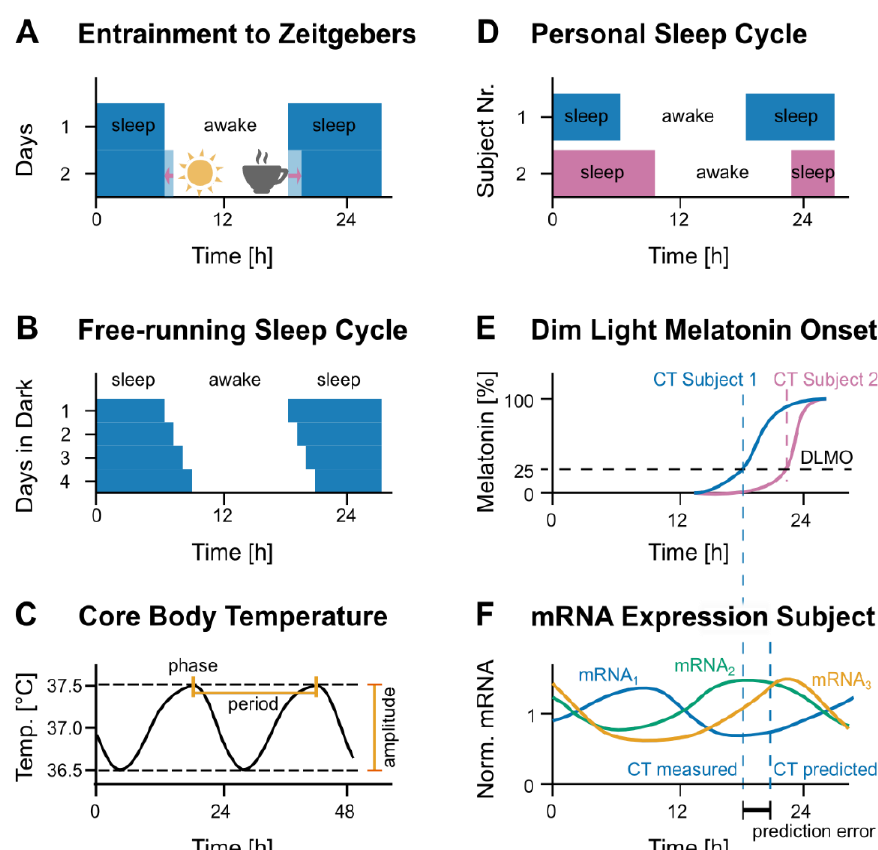
Figure 2. Circadian oscillations in humans. ( A ) The circadian rhythm is evident from the sleep / wake cycle of humans. Subjected to a normal day-night rhythm, humans are awake (white) and sleep (blue) with a period adapted to 24 h. Normally, the first light acts as a strong zeitgeber that entrains the subject to its rhythm. Other zeitgebers include temperature, food or the cup of co ff ee in the evening, which likely delays sleep onset. ( B ) Under constant light conditions, humans retain a rhythm of wake (white) and sleep (blue) phases with a period of around 24 h. In this example, the period is slightly longer than 24 h, thus shifting wake and sleep from day to day. ( C ) The core body temperature shows circadian oscillations. The phase (also named acrophase) is defined as the first peak of the oscillation, the time between two peaks is the period and the amplitude is the di ff erence between peak and trough. ( D ) Indicated are the awake (white) and sleep (colored) phases for two subjects. Subject 1 (blue) has an earlier phase than subject 2 (pink). ( E ) To measure the dim-light melatonin onset (DLMO), subjects are kept under dim-light conditions during the evening, with hourly sampling for subsequent melatonin quantification. The circadian phase is defined as the time when the concentration of melatonin reaches an absolute (e.g., 2 pg / mL) or relative (e.g., 25%) threshold [15]. ( F ) The analysis of circadian oscillations of a set of genes for a given subject (here visualized with profile sketches for three imaginary transcripts, mRNA 1 , mRNA 2 , mRNA 3 ) allows to predict the circadian time of that subject. The di ff erence between predicted and actual circadian time constitutes the prediction